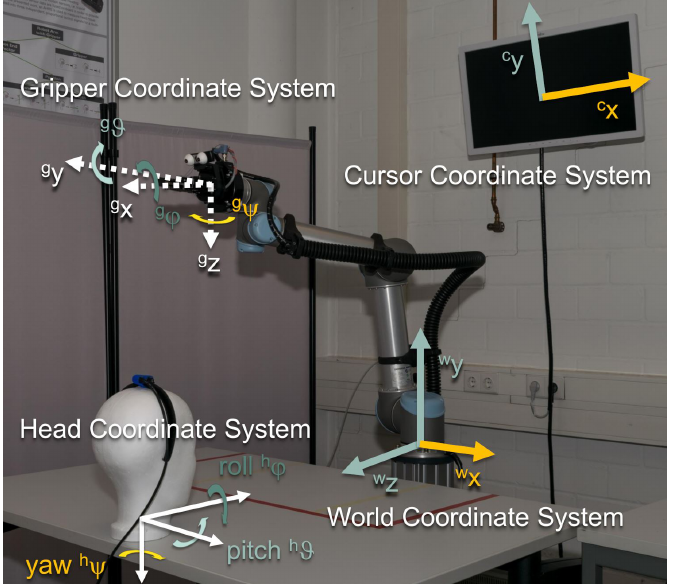
Figure 2. Coordinate systems of the AMiCUS system. Degrees of Freedom (DOFs) of the same color are controlled by the same head DOF. The zero orientation of the head coordinate system depends on whether the cursor or the robot is controlled. During robot control, the head coordinate system is denoted by ααα h r = ( ϕ , ϑ , ψ ) h r T and ααα h c = ( ϕ , ϑ , ψ ) h c T during cursor